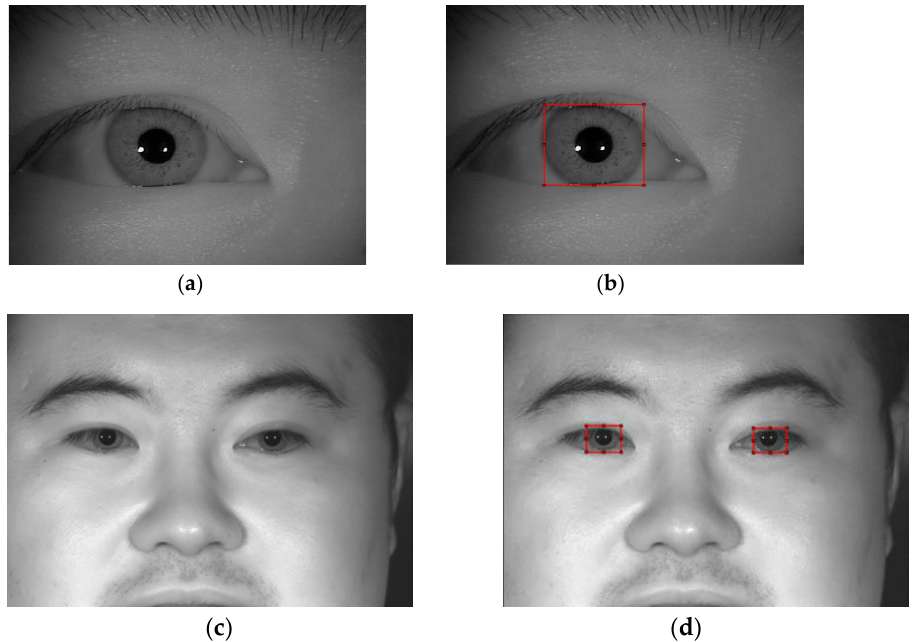
Figure 3. Sample image of the dataset used to train YOLO V4. ( a ) Example image of CASIA-Iris-Thousand; ( b , d ) Manual label of the outer boundary of the iris; ( c ) Example image of CASIA-Iris-distance [22].